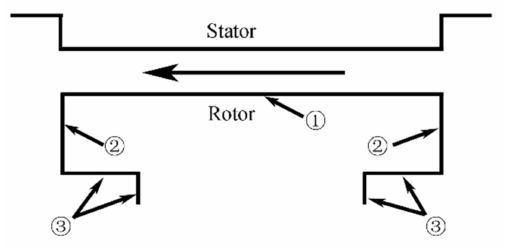
Figure 10. Schematic diagram of the rotor